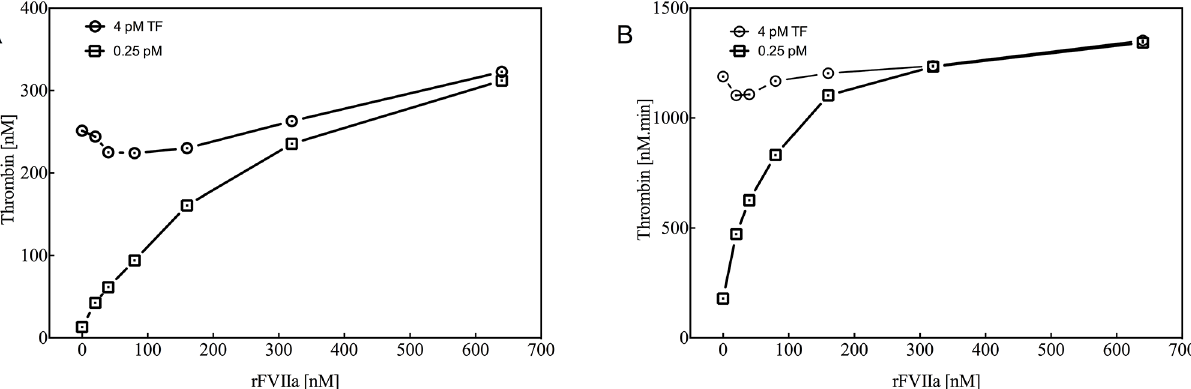
Fig 5. Contribution of rFVIIa to plasma thrombin generation assessed by the calibrated automated thrombogram and triggered with 0.25 (squares) or 4 (circles) pM tissue factor (TF) and 4 μ M phospholipids. Left panel: Maximum thrombin generation presented as the peak height (A). Right panel: endogenous thrombin potential (ETP;